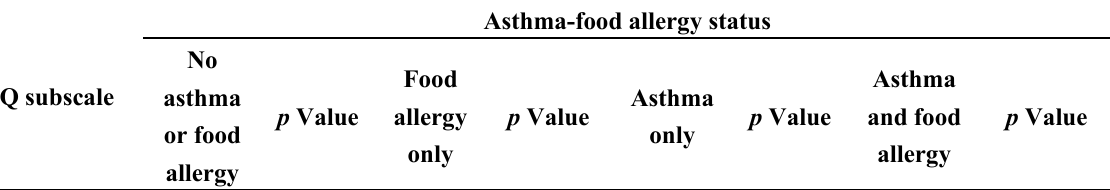
Table 5. Association of the CFQ subscales with parental perception of the child’s current weight status using Spearman’s rank-order